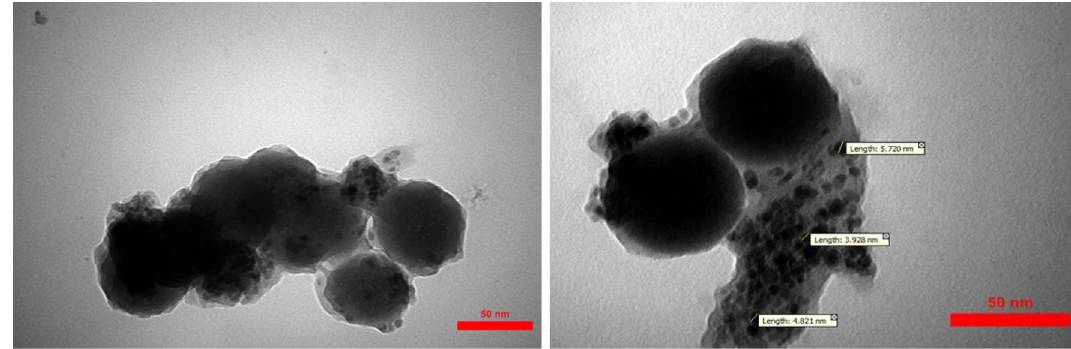
Figure 5. TEM images of Fe 3 O 4 @SiO 2